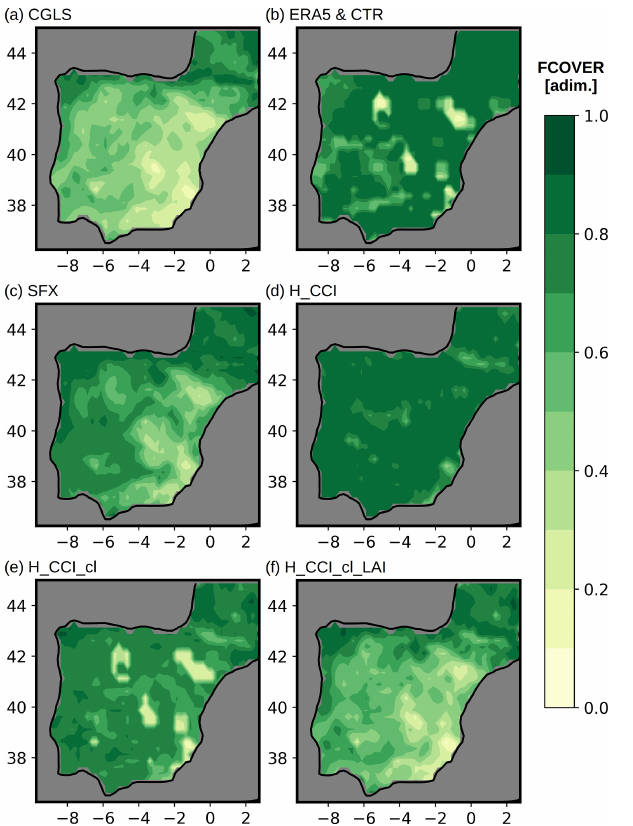
Figure 4. Fraction of green vegetation coverage (FCOVER) from (a) CGLS dataset, (b) ERA5 and CTR (the FCOVER is identical for these two datasets), (c) SFX, (d) H_CCI, (e) H_CCI_cl, and (f) H_CCI_cl_LAI.